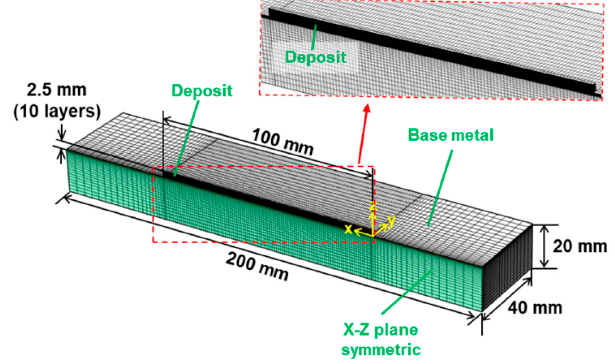
Figure 2. Mesh of numerical model for LMD simulation.